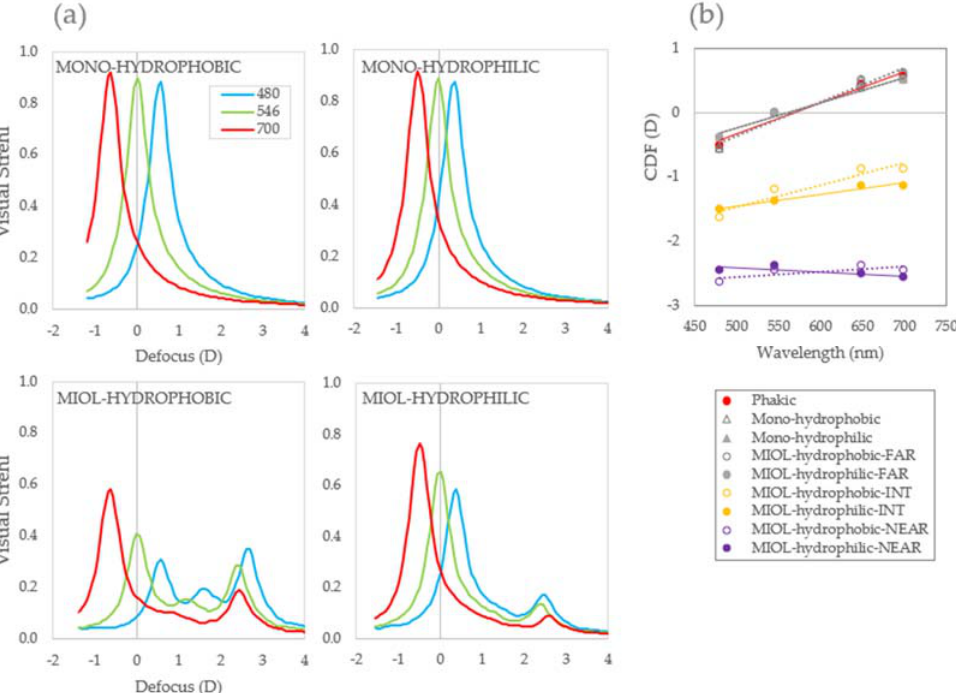
Figure 3. Computational ray tracing. ( a ) Visual quality metric in the form of Visual Strehl for pseudophakic model eyes (4 mm) in combination with both materials (empty circles with dotted lines hydrophobic and filled circles with continuous lines hydrophilic) and designs IOLs for blue (480 nm), green (546 nm), and red (700 nm), and ( b ) chromatic difference of focus (CDF) for all conditions.